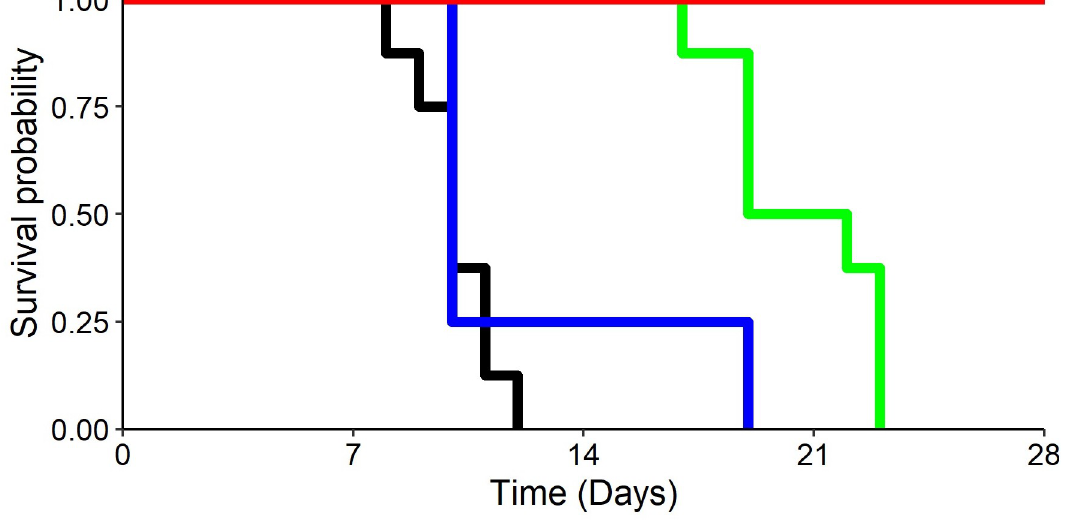
Fig 1. Observed survival according to treatment received. Black curve: animals receiving vehicle treatment; green: animals treated with RBV; blue: animals treated with FPV 150 mg/kg/day; red: animals treated with FPV 300 mg/kg/day.